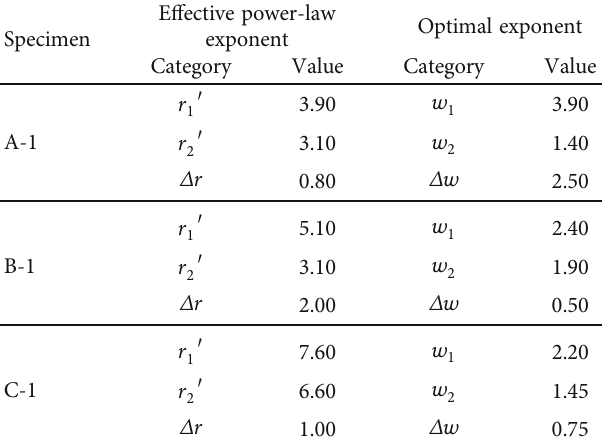
Table 3: Exponents of selected samples and their di ff erence values.